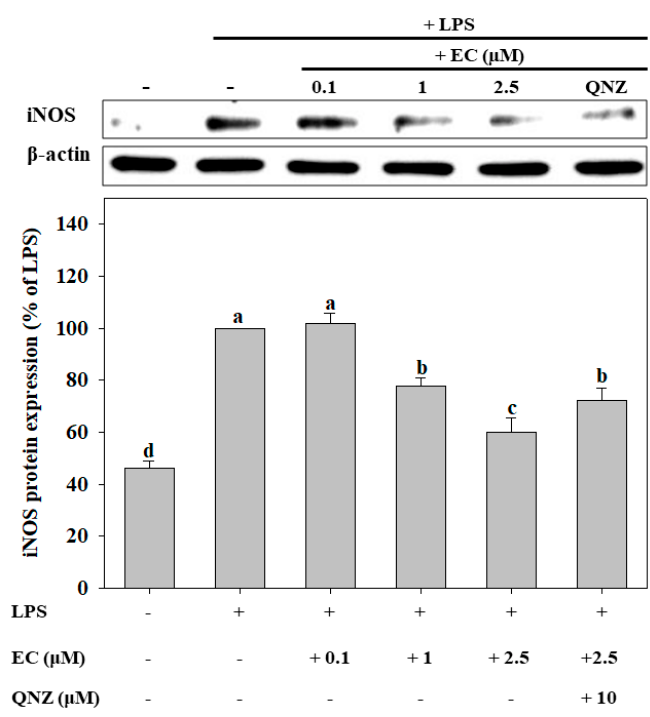
Figure 4. Effects of erinacine C (EC) on LPS-induced iNOS expression in BV2 microglial cells. Cells (1 × 10 5 cells/mL) were pretreated with different concentrations (0.1–2.5 µM) of EC for 1 h, after which the cells were treated with LPS (500 ng/mL) for 24 h. iNOS protein expression was determined by western blot analyses. Values (means ± SD, n = 3) not sharing a common lower case letter are significantly different ( p < 0.05). The western blot image is provided as a representative result of multiple experiments.